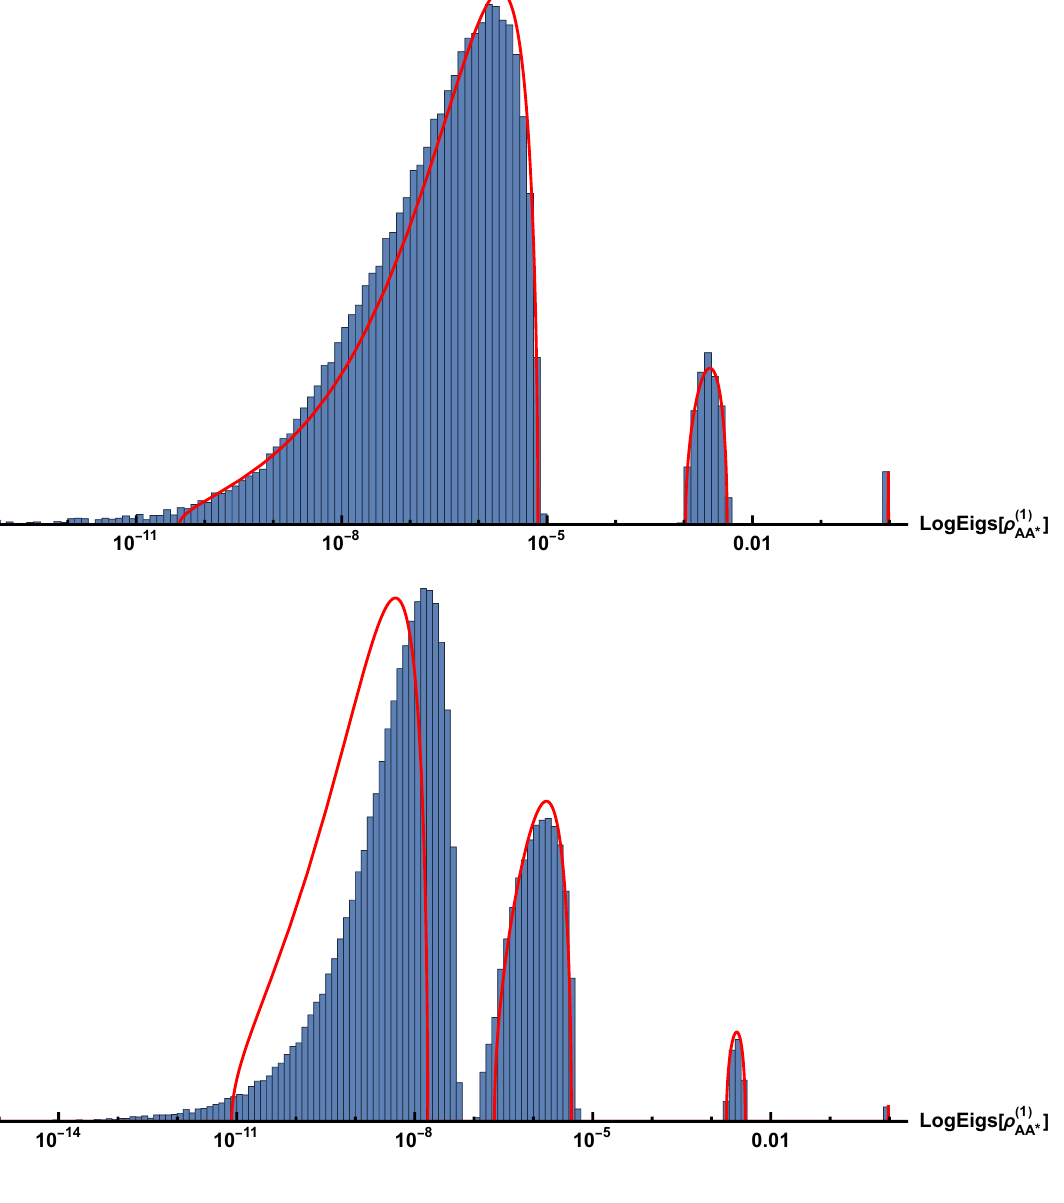
|√ h√ ≡ Tr BB ∗ ρ AB i ρ AB | AB